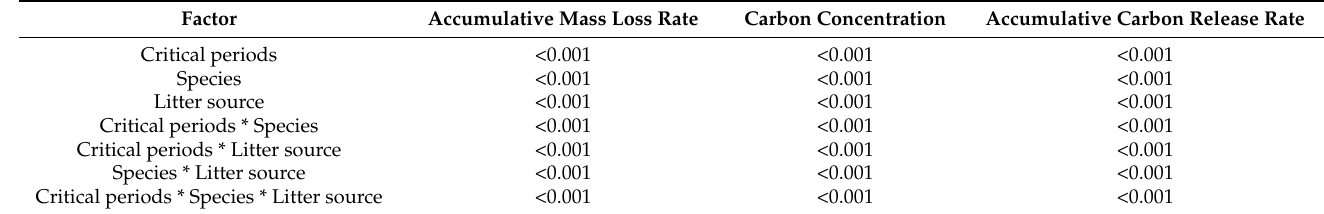
Figure 3. The daily mass loss of goldenrain tree ( a ), camphor tree ( b ), and weeping willow tree ( c ) foliar litter during different critical periods in the urban forest. ALP, WNG, SLP, EPR, and LPR indicate the autumn litter peak period, winter non-growing season, spring litter peak period, early plum-rainy season, and late plum-rainy season, respectively. PL and AL indicate physiological and abnormal litter, respectively. Different capital letters indicate significant differences between different critical periods ( p < 0.05). Different lowercase letters indicate significant differences between different sources of foliar litter ( p < 0.05). Table 3. Results of repeated-measures ANOVA showing the p values for responses of accumulative mass loss rate, carbon concentration, and accumulative release rate to critical periods, species, and litter